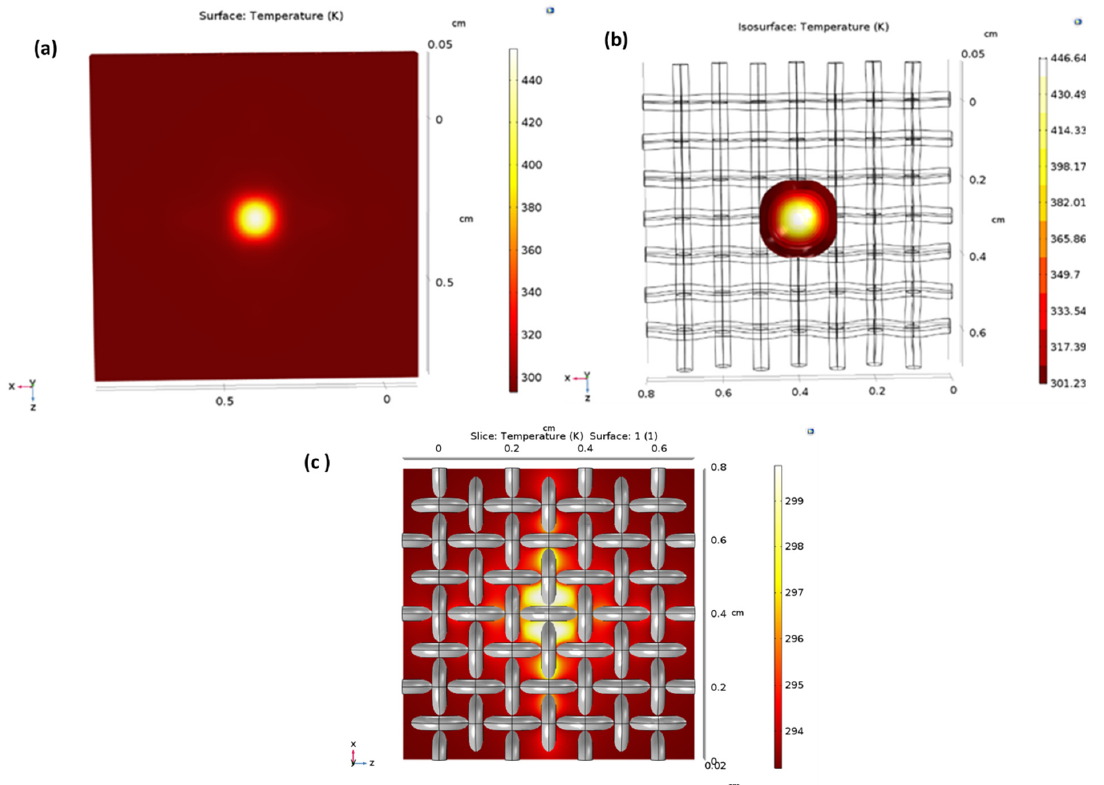
Figure 9. ( a ) Temperature distribution on the surface ( b ), with a fiber-oriented position ( c ) temperature at the center area with a fiber structure.